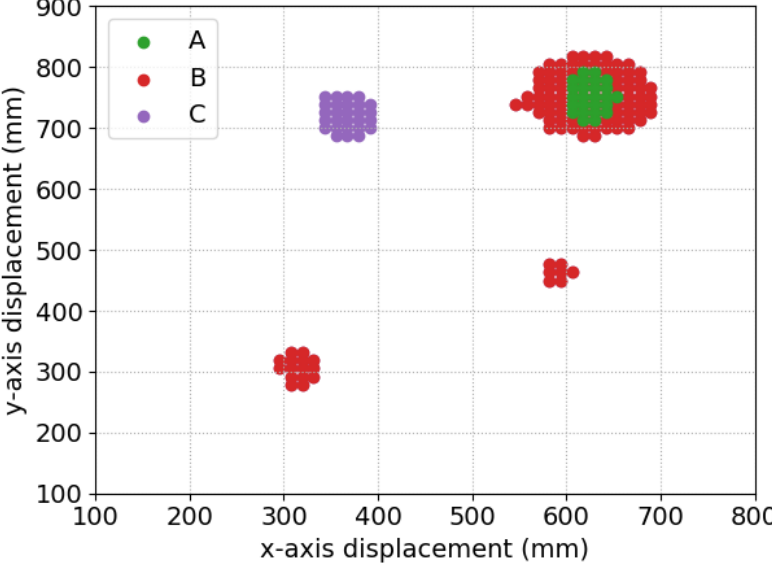
Figure 16. Detections based on the three different threshold